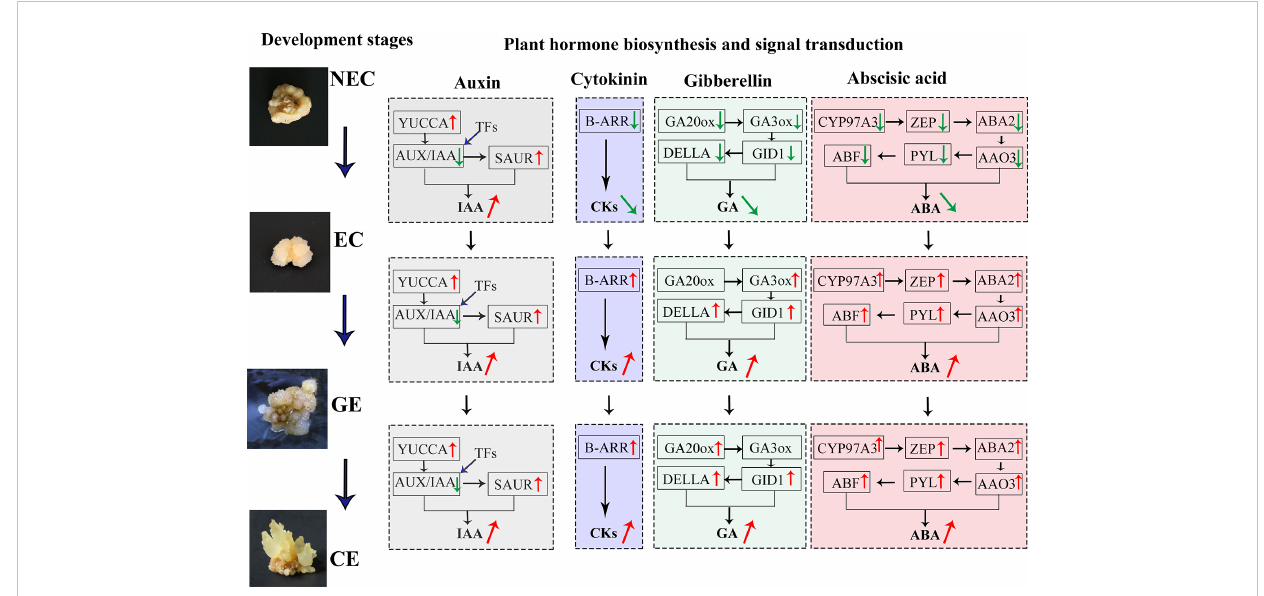
FIGURE 8 DGEs and TFs of endogenous hormone biosynthesis and signal transduction regulated SE process at different stages in O.